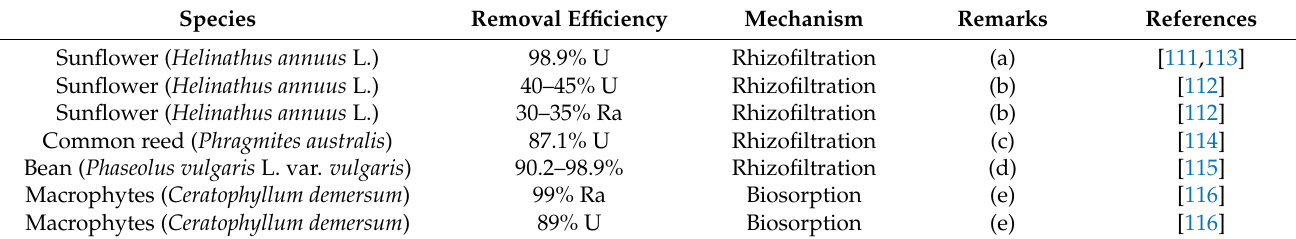
Table 6. Summary of the phytoremediation performance for uranium and radium removal.